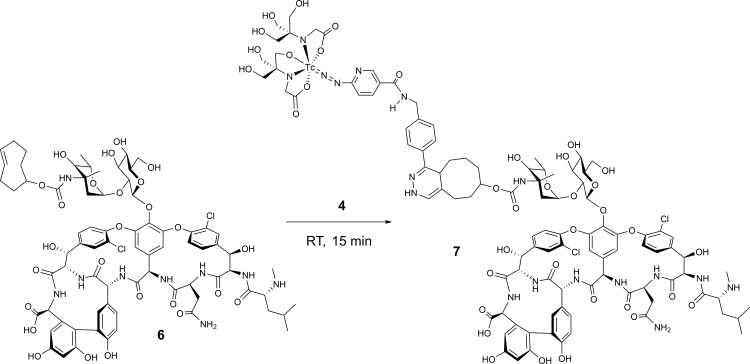
Synthesis scheme for 99mTc-HYNIC-tetrazine-TCO-vancomycin (7) from TCO-vancomycin (6) and 4.